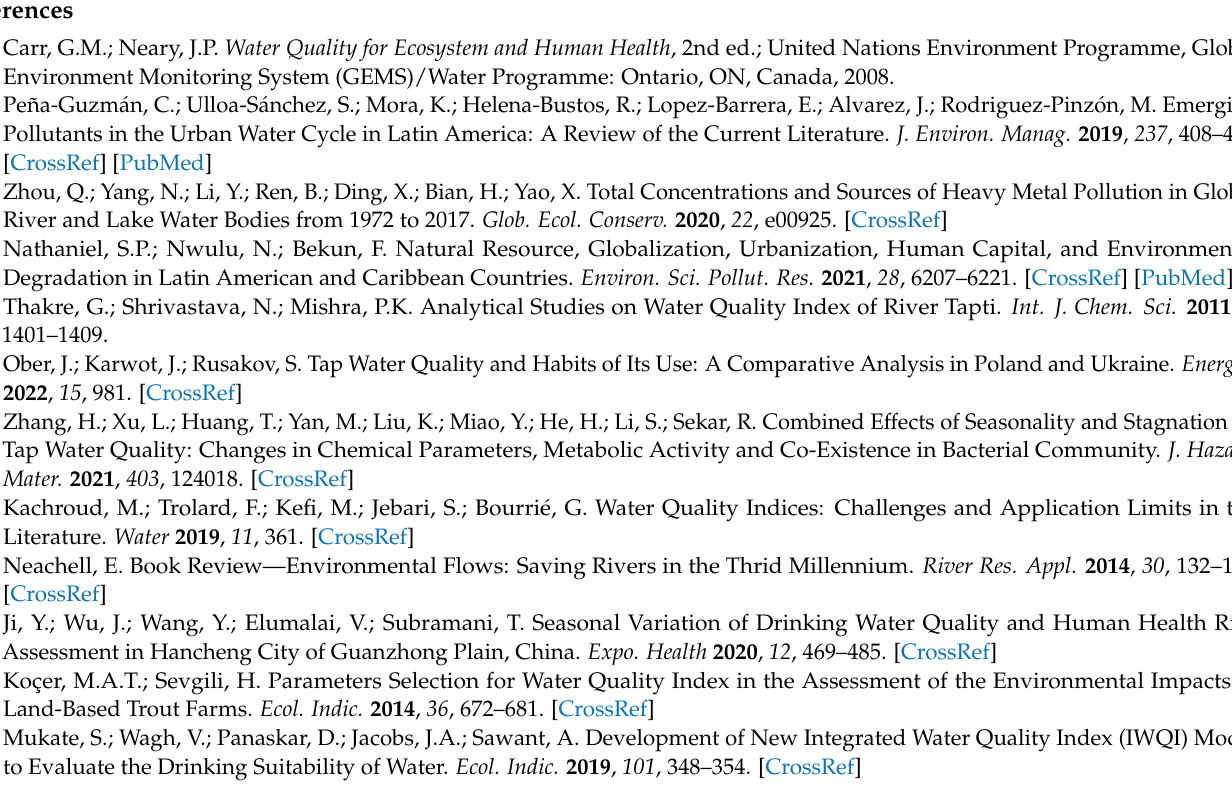
in El Pueblito river, Figure S4: Variation of total solids in different sampled sites of El Pueblito river, Figure S5: Variation of volatile suspended solids in different sampled sites of El Pueblito river, Figure S6: Variation of BOD 5 at the different sampled sites in El Pueblito river, Figure S7: Variation of COD per week at the different sampled sites in El Pueblito river, Figure S8: Variation of total phosphorous per week at the different sampled sites in El Pueblito river, Figure S9: Variation of total coliforms expressed as MPN per week in the different sampled sites in El Pueblito river, Figure S10: Variation of LC 50 Daphnia magna, the samples’ concentration in % volume/volume per week at different sampled sites in El Pueblito river, Figure S11: Germination bioassay with sorghum, percentage of rooth growth inhibition against blank per week at different sites in El Pueblito river, Figure S12: Germination bioassay with sorghum, percentage of epicotyl growth inhibition against blank per week at different sites in El Pueblito